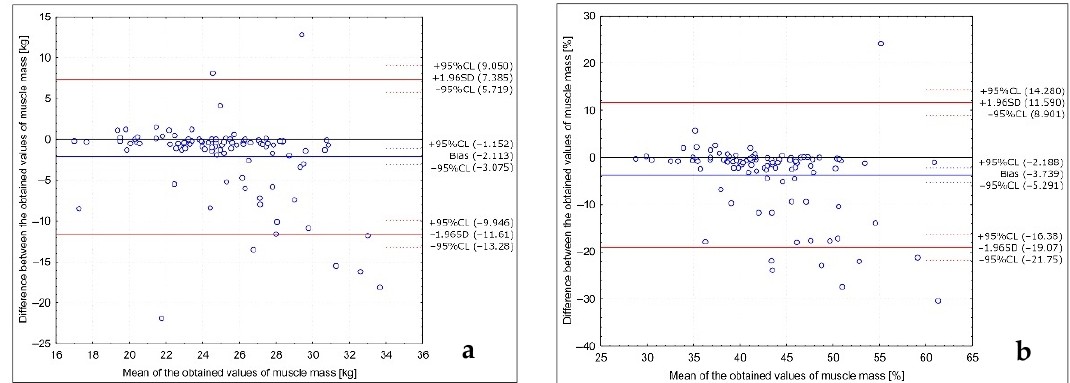
Figure 4. Analysis of the Bland–Altman plots comparing the muscle mass results in the studied group of Caucasian young normal body mass women measured in the follicular phase in various positions (with arms abducted at least 30° and legs abducted at approximately 45°; with arms and legs separated to not touch the body) for the results in kg ( a ) and in the % ( b ).